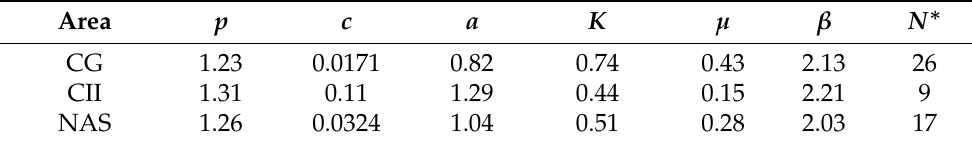
Table 5. Generic ETAS parameter values for the three study areas. N ∗ denotes the number of sequences with N ≥